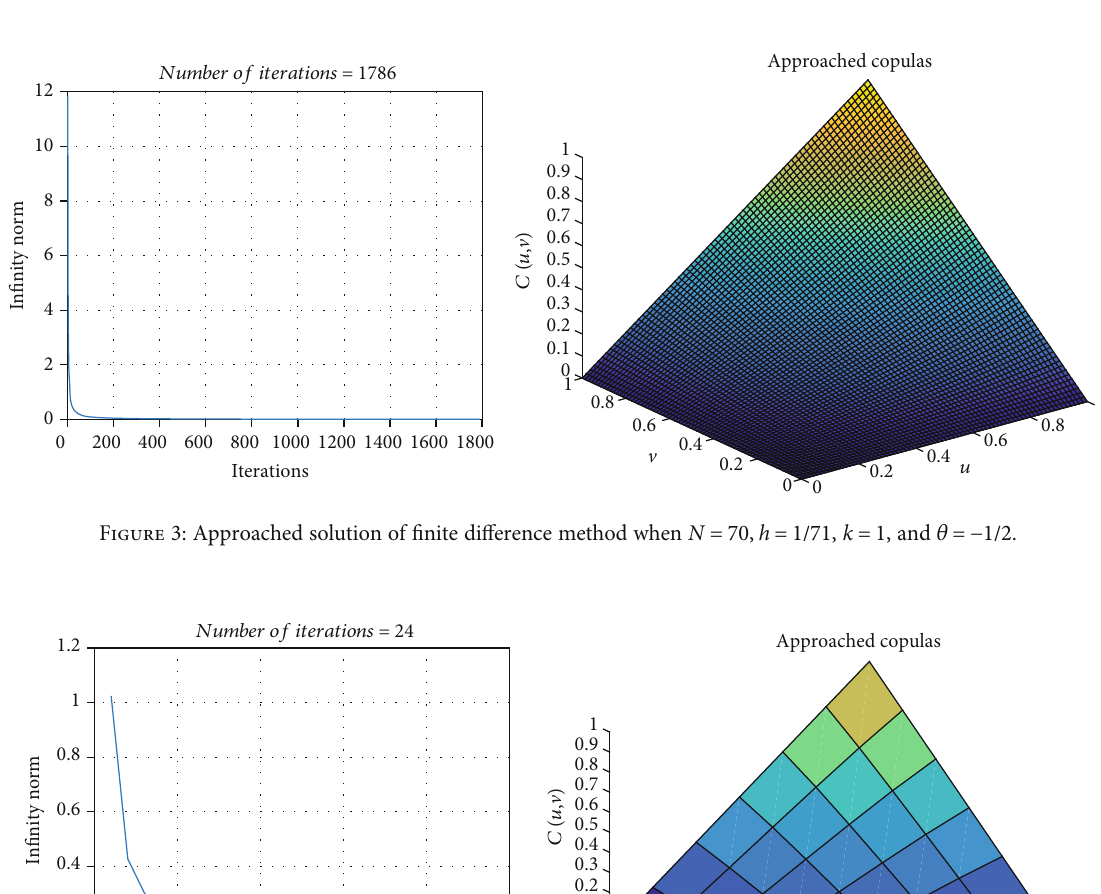
Figure 2: Approached solution of fi nite di ff erence method when N = 50, h = 1/51 , k = 2 , and θ = 3 .